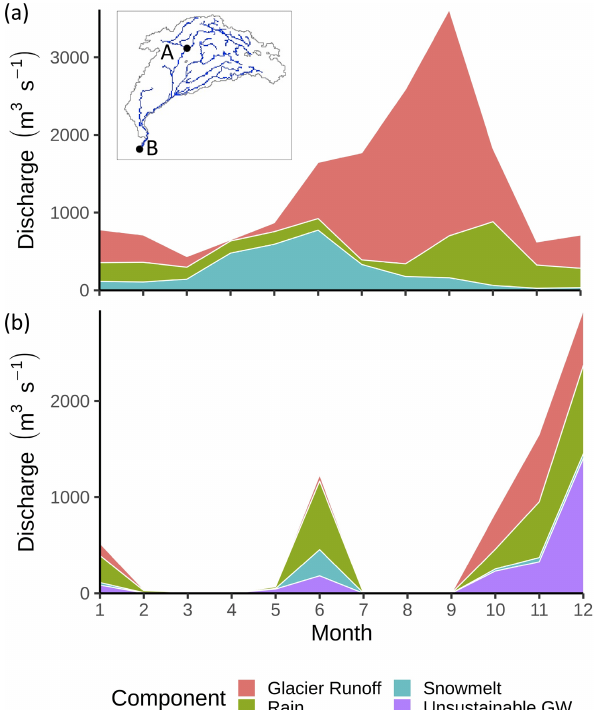
Figure 10. Monthly discharge by primary source component at two points (A shown in panel a , B shown in panel b ) along the Indus River (basin shown in inset). Point A is in the headwaters, with sub- stantial contributions from snowmelt and glacier runoff. Point B is the river mouth. The mouth of the Indus River runs dry in this simu- lation due to both the seasonality of precipitation in the monsoonal region, and the large amounts of water extracted from the river for use. This use and re-use of water can be seen in the distribution of primary water sources remaining at the mouth of the river, which include unsustainable groundwater (purple) that was pumped from upstream sources, as well as snowmelt (blue) and glacier runoff (red), both of which are generated far upstream of the river